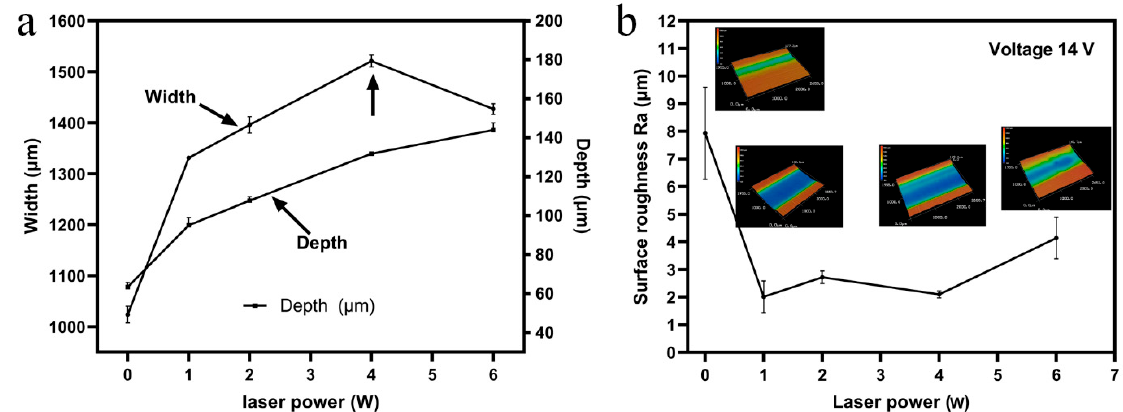
Figure 5. ( a ) Variation of the width and depth of the microgrooves fabricated by Laser-STEM with laser power. ( b ) Variation of the surface roughness Ra of the bottom of the microgrooves with laser power.